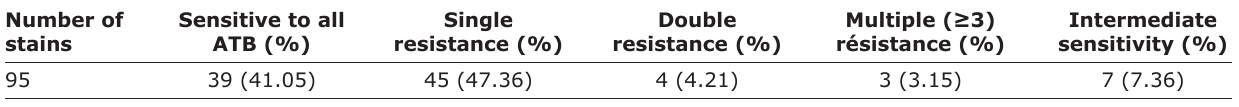
Table-2: Resistance profile of S. aureus isolates to antibiotics. Number of